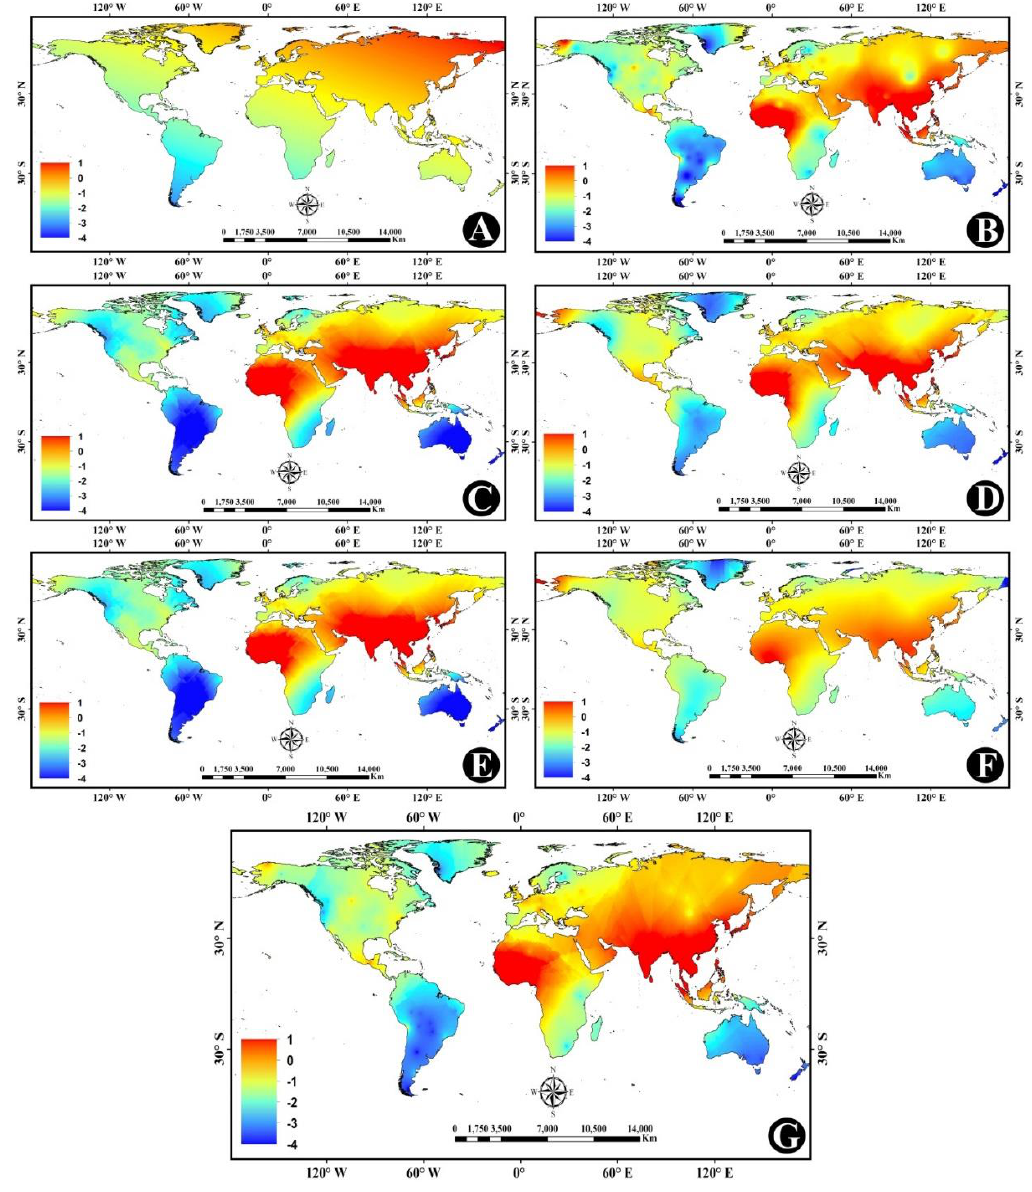
Fig 3: Interpolation maps of aerosol optical depth for spring. A) GPI, B) IDW,C) K_D, D) K_O, E) K_S_, F) LPI and G)